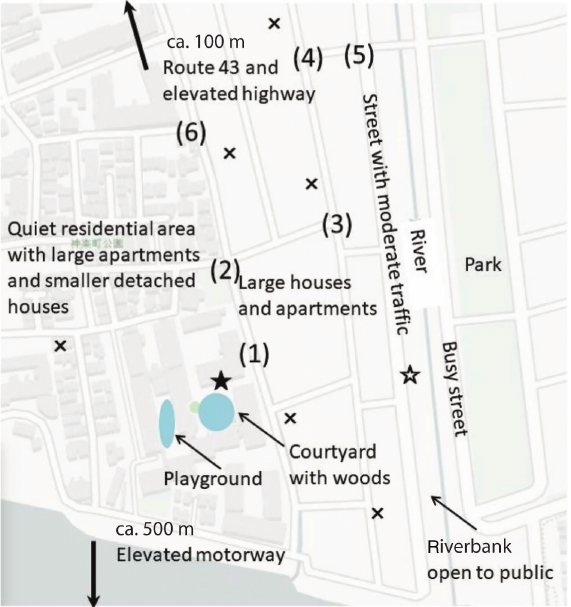
Map of the surveyed area (eastern edge of Kobe city). The numbers (1) to (6) show measuring points. The black star is the measuring point for fixed-point observation. The white star is the measuring point for monitoring noise levels in the public space (river). The Xs show construction